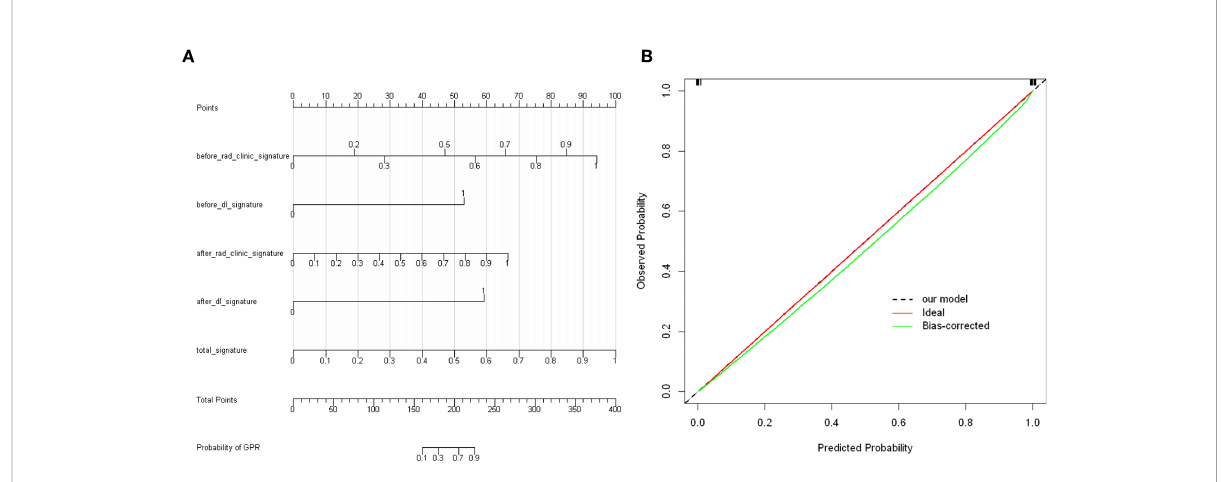
FIGURE 15 (A) After_nomogram.Locate on the before_rad_clinic_signature, before_dl_signature, after_rad_clinic_signature, after_dl_signature, and entire_signature coordinate axis. Draw a straight line perpendicular to the fi rst points, calculate and sum the scores corresponding to each straight line, locate on the total points coordinate axis, and draw a straight line perpendicular to the horizontal axis of the probability of GPR. The corresponding value is the probability of pathological response to GPR in patients with non-small cell lung cancer after neoadjuvant immunotherapy. (B) Calibration curve corresponding to after_nomogram. The consistency between the probability of GPR predicted by the nomogram after 1,000 repeated samplings and the actual GPR. The 45° red line represents the ideal prediction performance. The black dotted line and the solid green line represent the prediction performance of the nomogram and the correction of the deviation of the nomogram, respectively. The closer the black dotted line is to the 45° ideal red line, the higher the model ’ s prediction